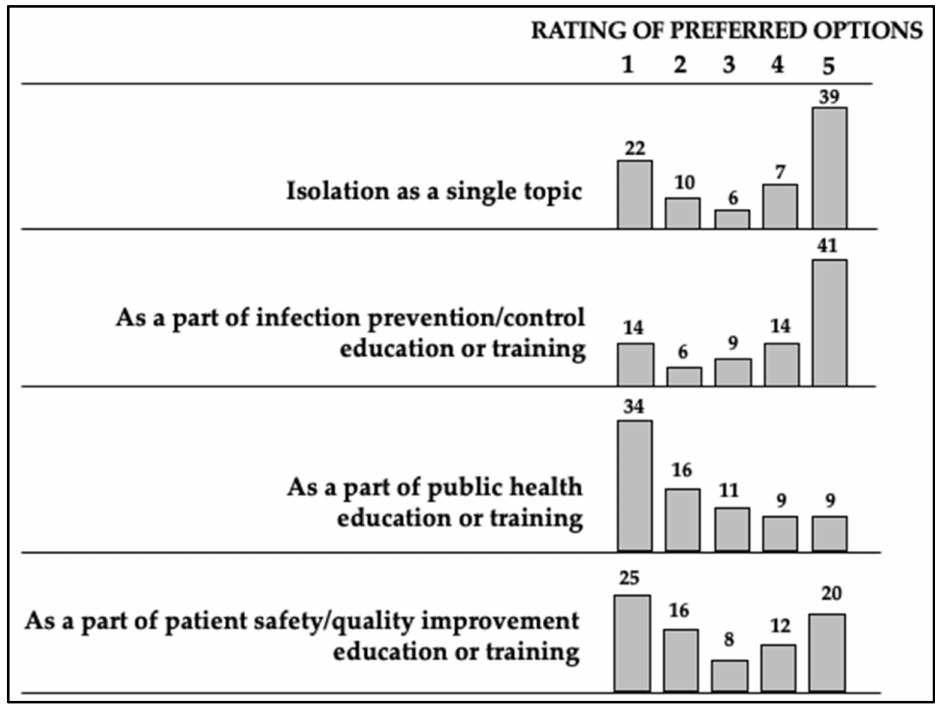
Figure 1. Ratings (1—lowest, 5—highest) for preferred options for antimicrobial stewardship edu- cation and training to be delivered. Percentages are depicted above each column, all the remained respondents (up to the total of 100%) did not rate the option during the